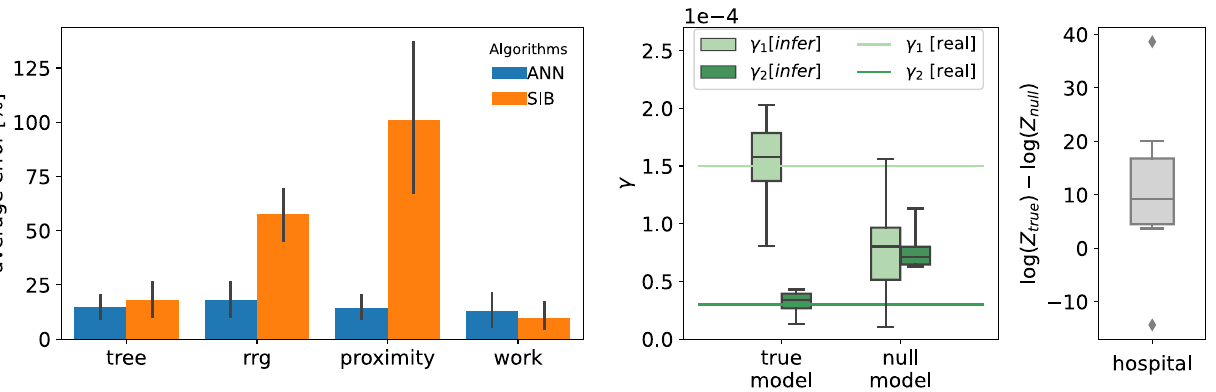
Figure 6. Inference of epidemic infectiousness parameters. Left plot . Average relative error in the inference of the infectiousness parameters over ten epidemic cascade per interaction graph. On tree , rrg and proximity networks, the discrete-time SIR model has infection probability respectively equal to (cid:31) (cid:31) (cid:31) − 3 . The initial tree = 0.35, rrg = 0.04, proximity = 0.03 . The work case has rate of infection γ work = 10 conditions for the parameter learning process were set to (cid:31) init = 0.5 for tree , (cid:31) init = 0.1 for RRG and proximity networks and to γ init = 10 − 2 for the work network. Central plot. Box plot for the case of two classes of individuals with different rate of infection γ 1 , γ 2 inferred by the ANN. We consider two inference model where the population is divided according the propagation model ( true model) and randomly ( null model), see the text for details. The true model is able to correctly infer the parameters with only ten different epidemic cascade. Right plot . Box blot of the log-likelihood difference between the true and null